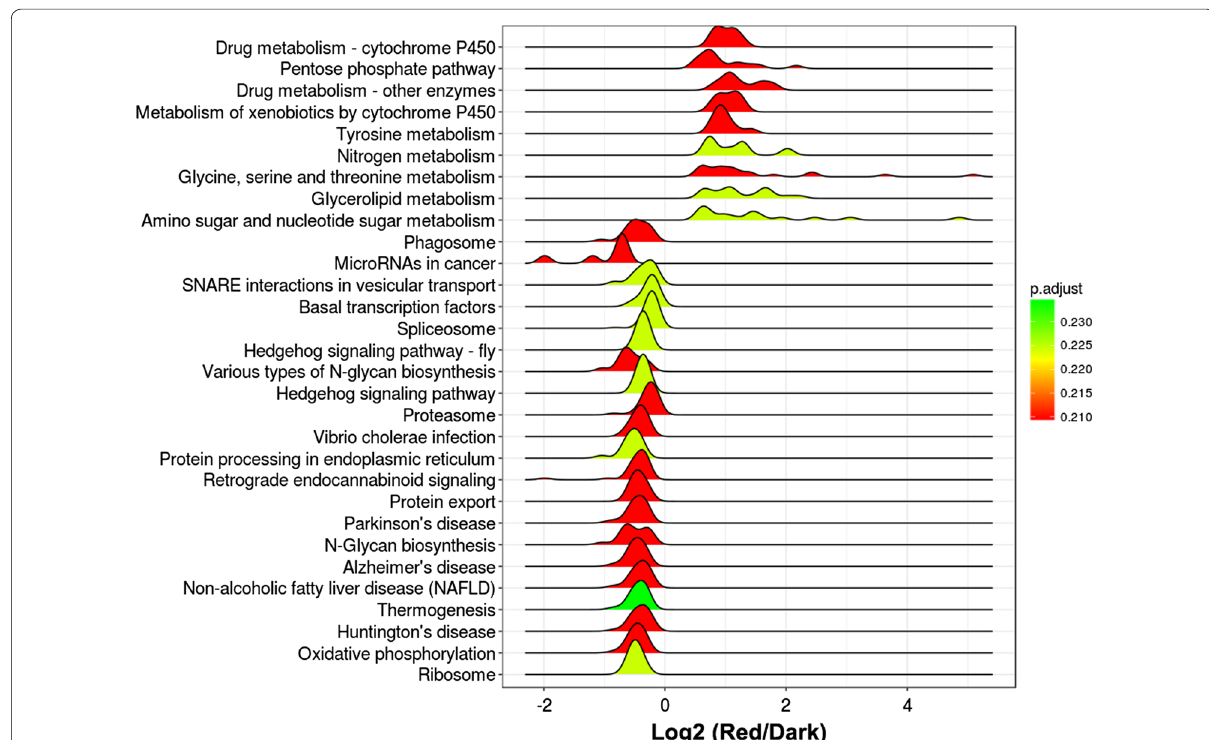
Fig. 3 KEGG enrichment of different genes expressions in the pileus between red-light treatment and dark treatment. Fold changes (red-light/dark) of all the expressed genes were subjected to GSEA-KEGG